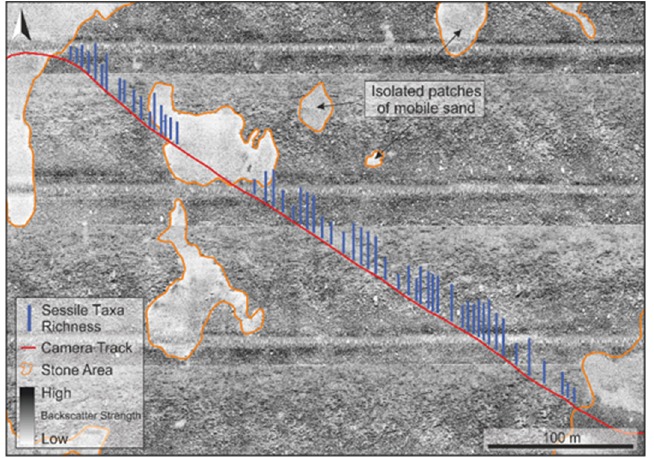
Figure 8. Abundance of sessile taxa across the rocky reef. The richness decreases toward the sandy patches.